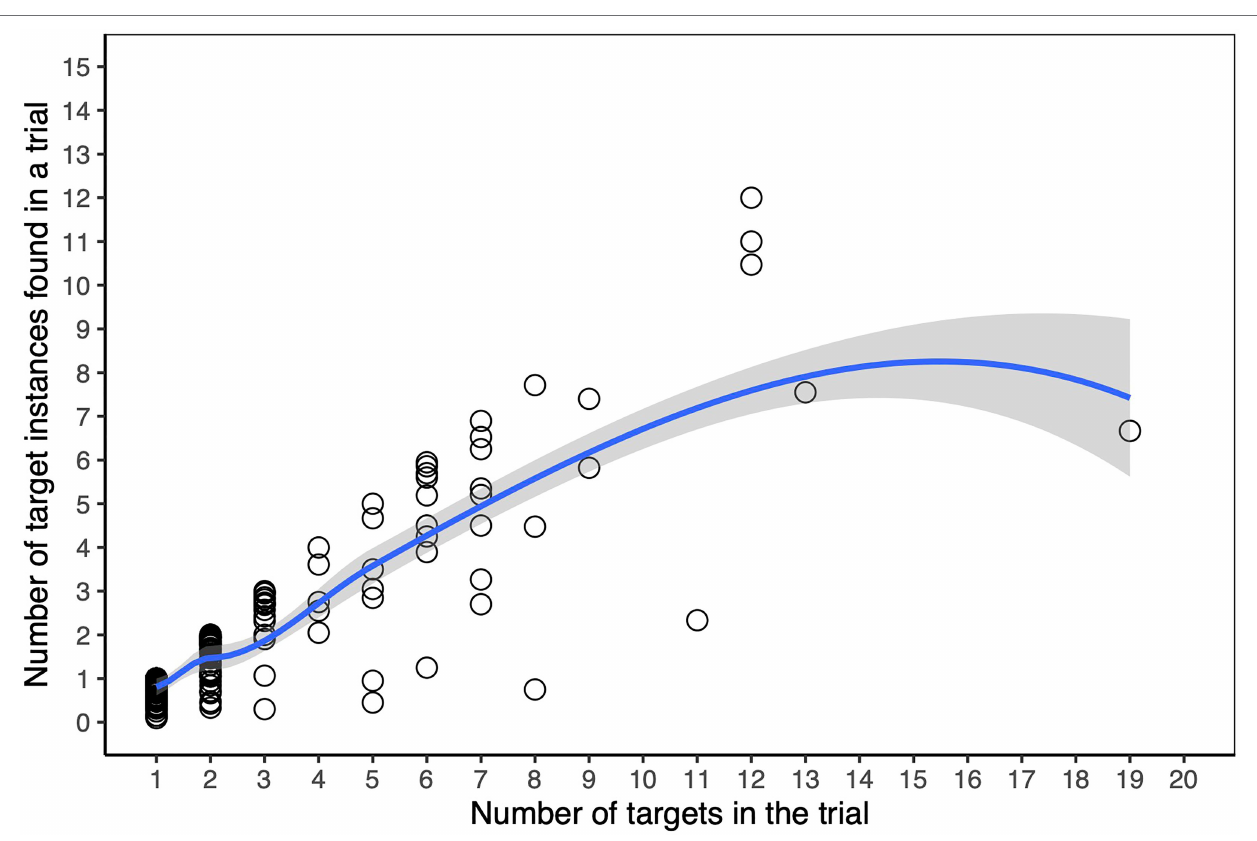
FIGURE 6 | Number of targets found vs. number of targets in the trial, Experiment 2. Each dot represents a given trial, and the y -axis indicates the average number of targets found (across participants) in that trial. The line is a loess